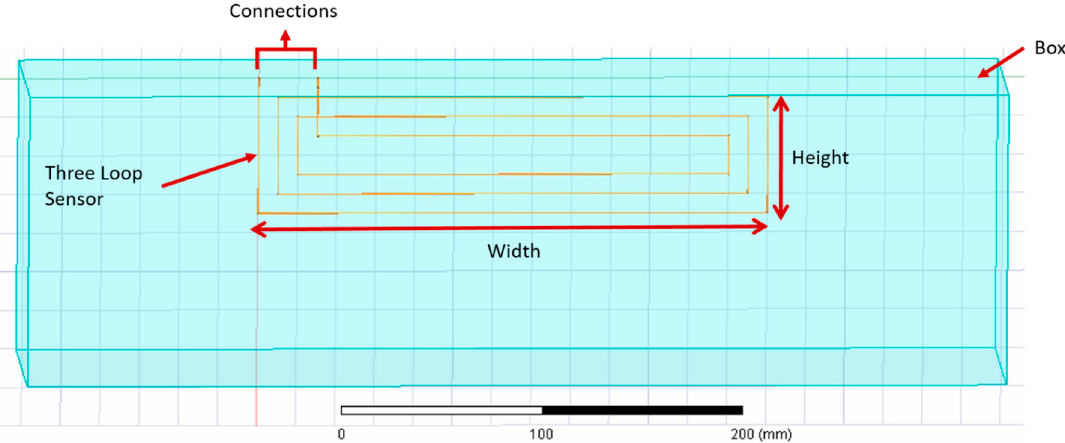
Figure 11. Flat rectangular coil with three turns simulated in Ansys.